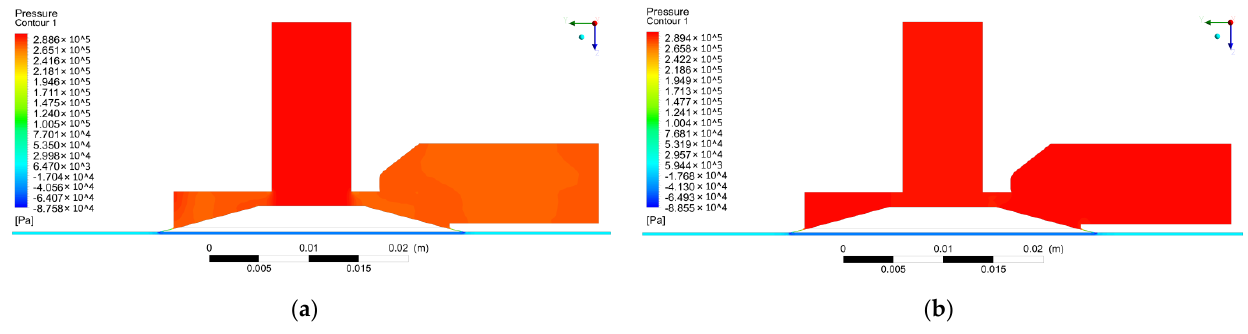
Figure 7. Pressure distribution on the plane of symmetry of a BGD: ( a ) inlet vertical; ( b ) inlet horizontal.